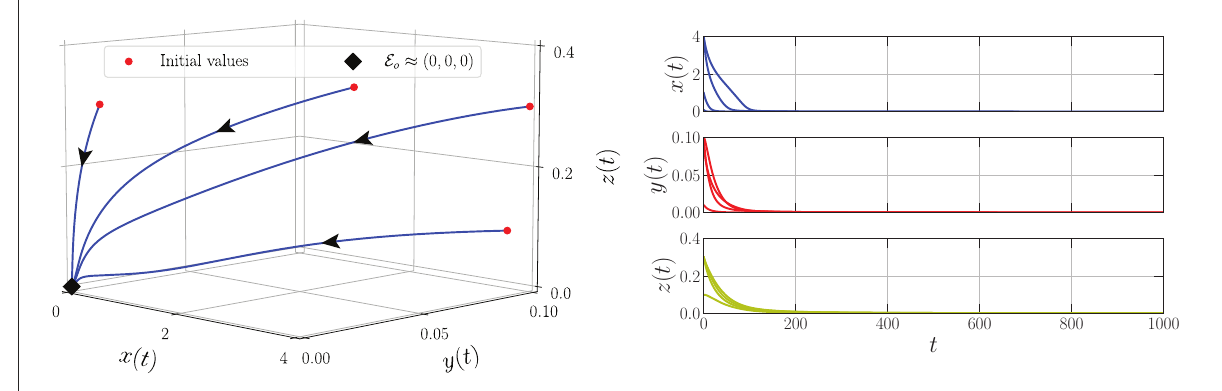
FIGURE4 Phase portrait and time series of the model (Equation 3) using parameter values: r = 0.1, K = 5, m = 0.25, c = 0.5, n = 0.01, β = 0.06, δ 1 = 0.05, δ